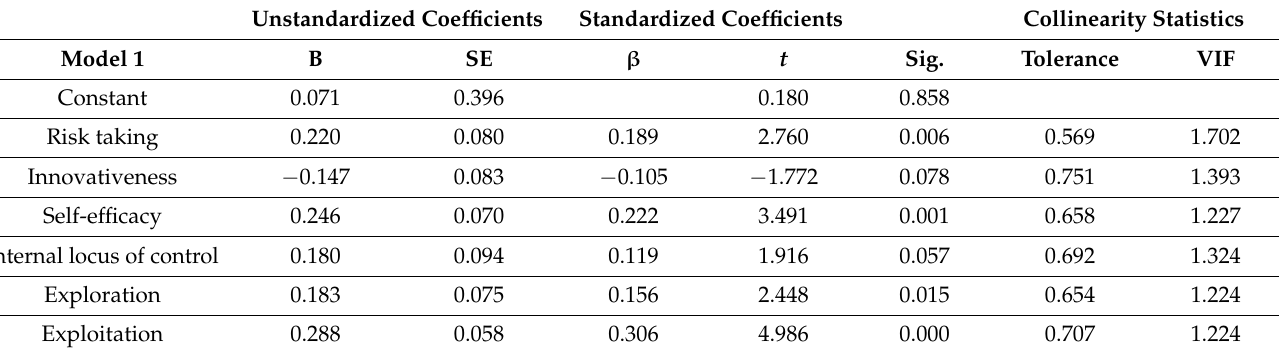
Table 4. Results of multicollinearity